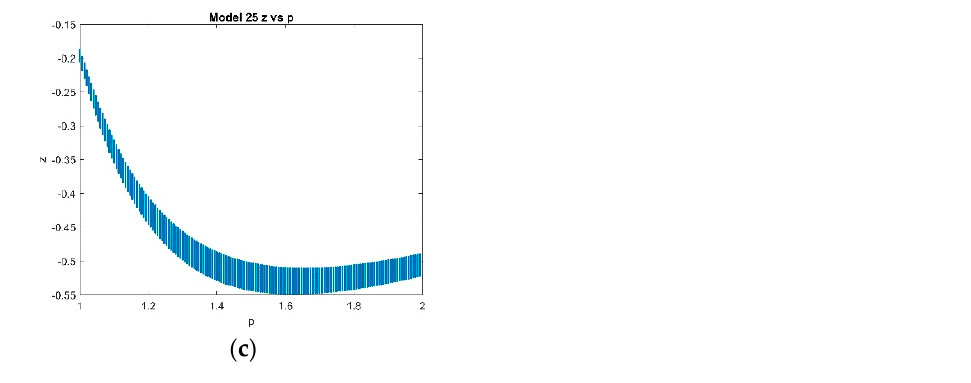
Figure 15. ESDDFD2 model (25); ( a ) u vs. p , ( b ) x vs. p , ( c ) z vs. p , at k = 2, α 5 = 0.3, p ∈ [ 1, 2 ] . Setting p = 1.94, phase portraits are given for models (22) through (25) in Figure 16. Figure 17 shows the phase portraits for model (21). There are clear signs of chaos in the phase portraits for model (21) and no chaos in those for the other models.